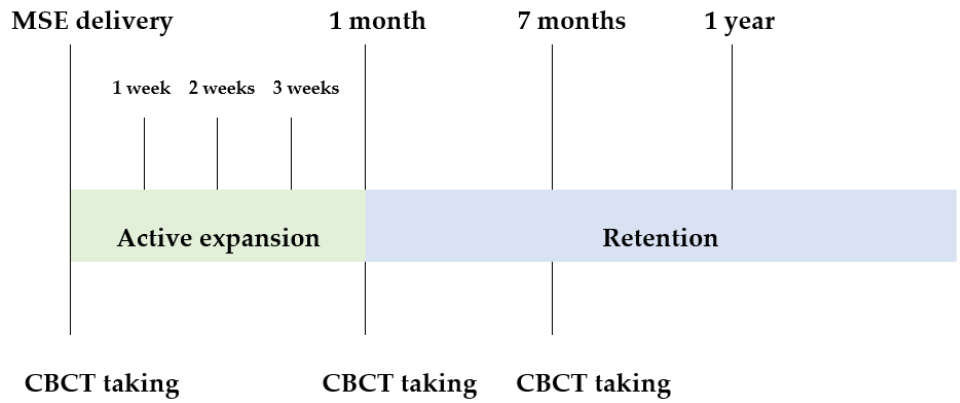
Figure 2. MSE treatment protocol.